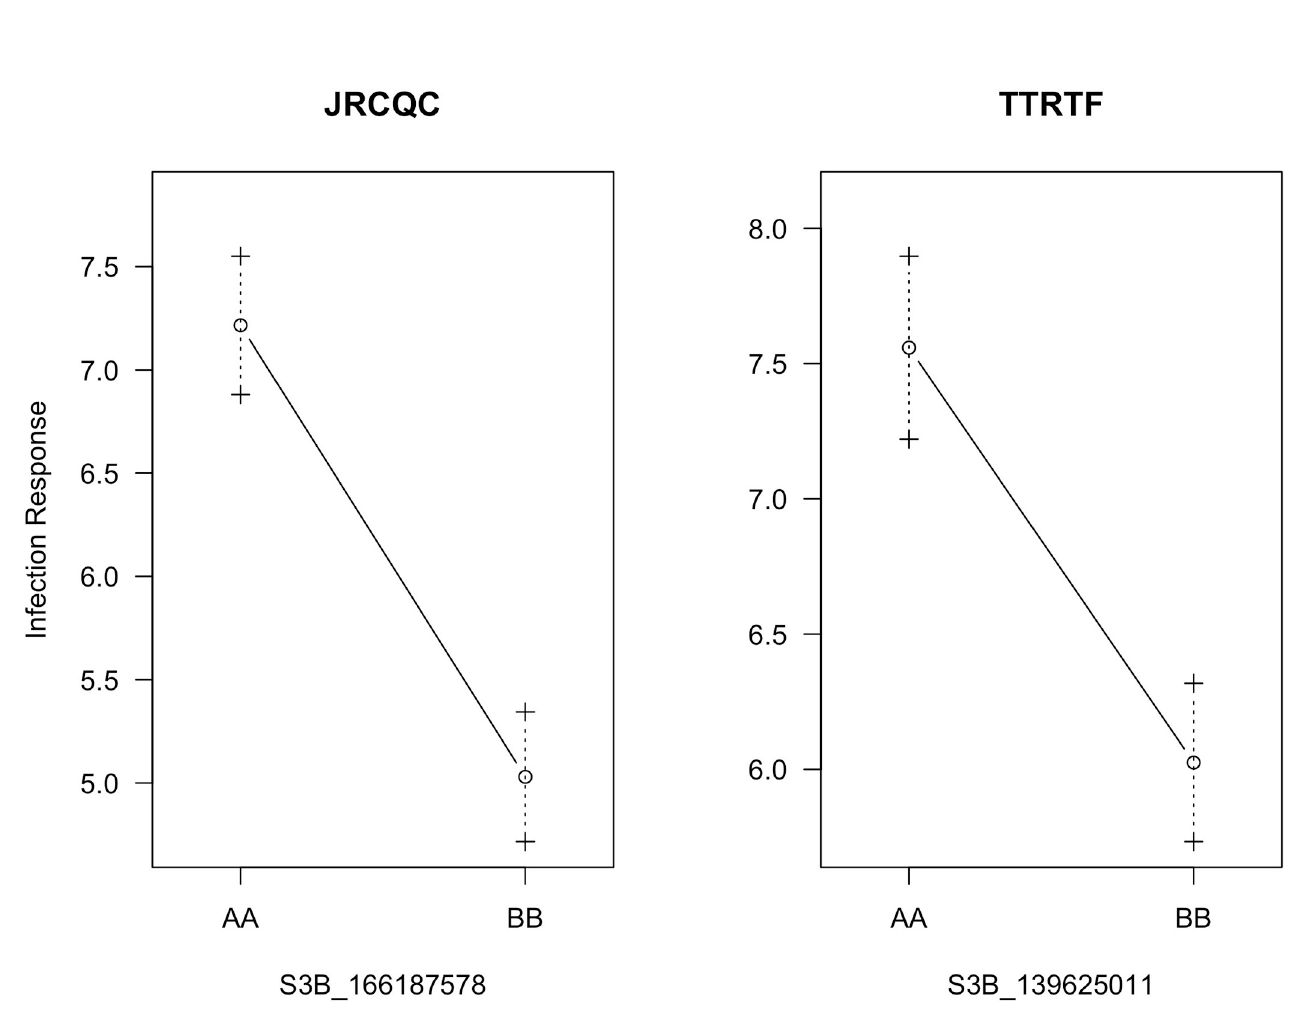
Fig 6. Effects of QTL on the response of RILs to races JRCQC and TTRTF, the A allele was from the susceptible parent (‘DAKIYE’) and the B allele was from the resistant parent (‘Reichenbachii’).